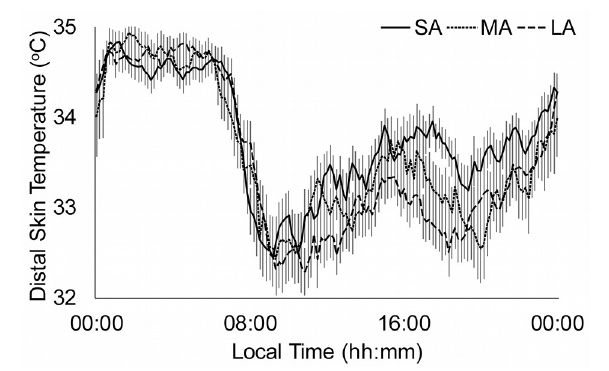
FIGURE 3 | Distal skin temperature mean daily patterns for duration of abstinence. Continuous line represents short abstinence (SA, n = 38), dotted line medium abstinence (MA, n = 35) and discontinued line long abstinence (LA, n = 41). All data are expressed as mean ± standard error of the